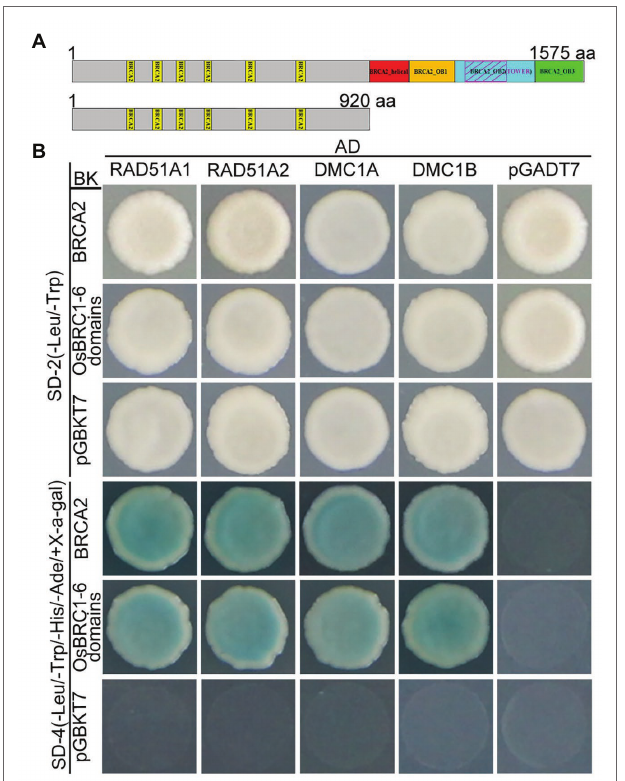
FIGURE 8 | Interactions among OsBRCA2 and OsRAD51 paralogs. (A) A schematic diagram of OsBRCA2 and the truncation containing BRC1-6 motifs used in the following yeast two-hybrid assay is shown. (B) Yeast two- hybrid (Y2H) assay for interaction of OsBRCA2 with OsRAD51A1, OsRAD51A2, OsDMC1A, and OsDMC1B which verified on the SD-4 (-Leu/-Trp/-His/-Ade/+ X- α -gal) selection medium.